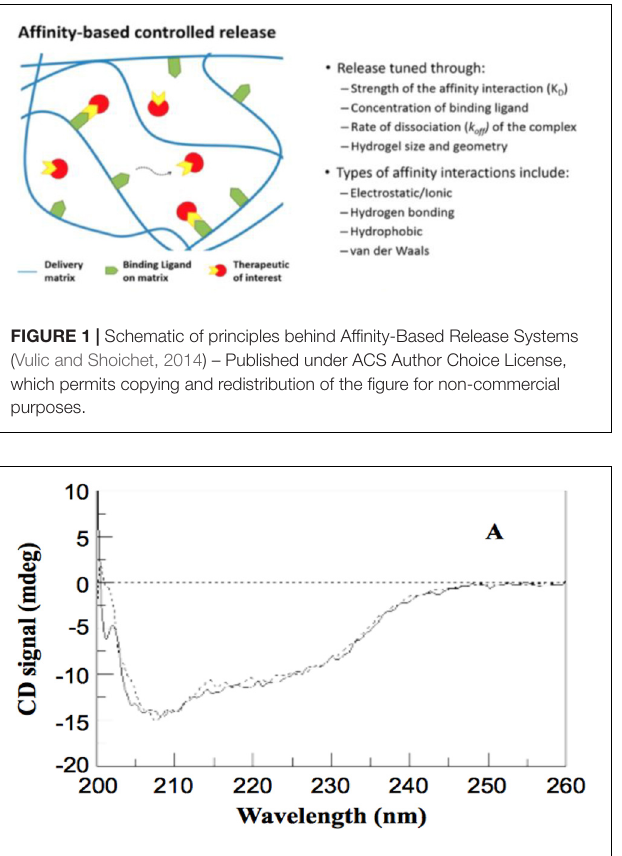
Frontiers in Neuroscience |